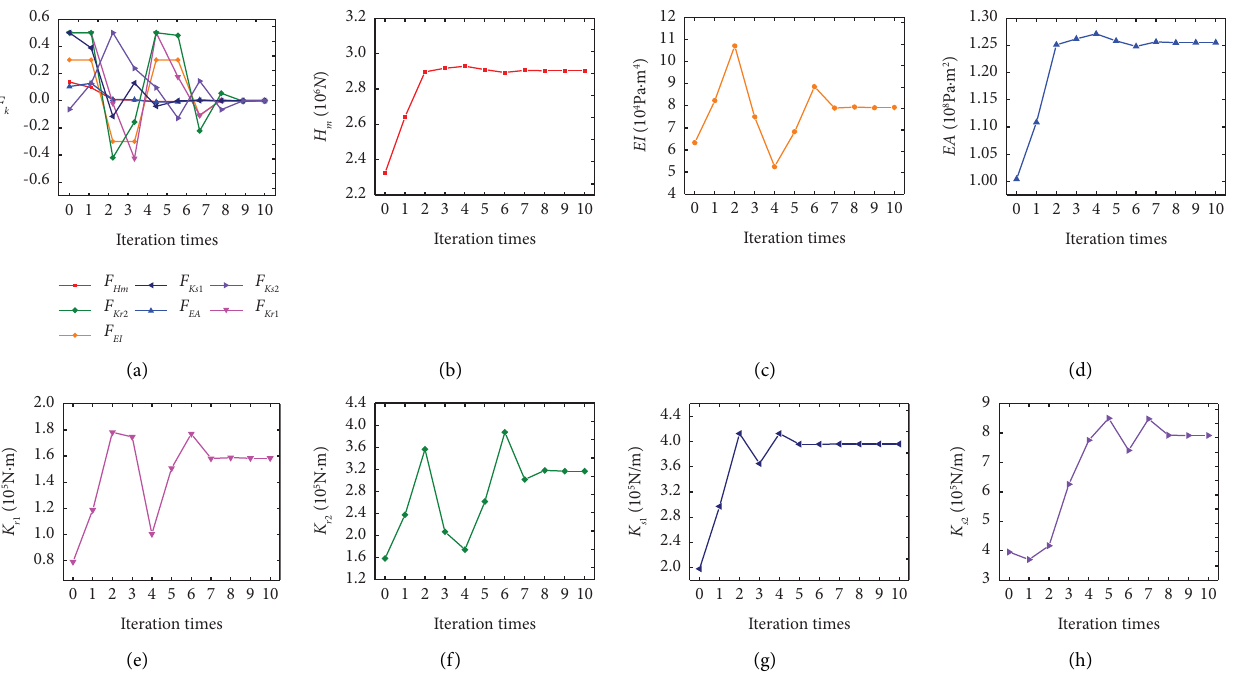
k , (b) H m , (c) EI, (d) EA, (e) K r 1 , (f) K r 2 , (g) K s 1 , and (h) K s 2 of cable 1 during the